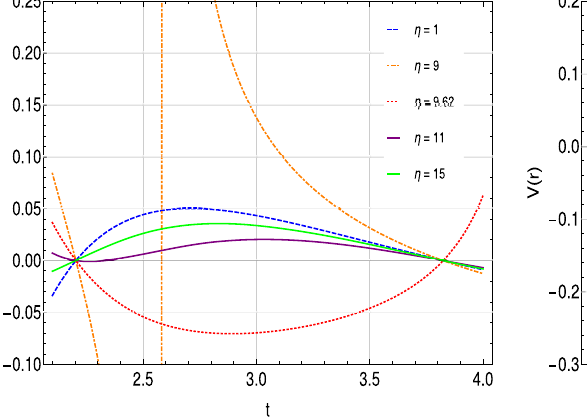
r h / 2 . 204 = r c / 3 . 825 = 1. Right panel: Potential for regions (i)–(iv) of Table 3. The two last η lie on region (iv). The horizon locations are r h / 1 . 703 = r c / 4 . 669 ∼